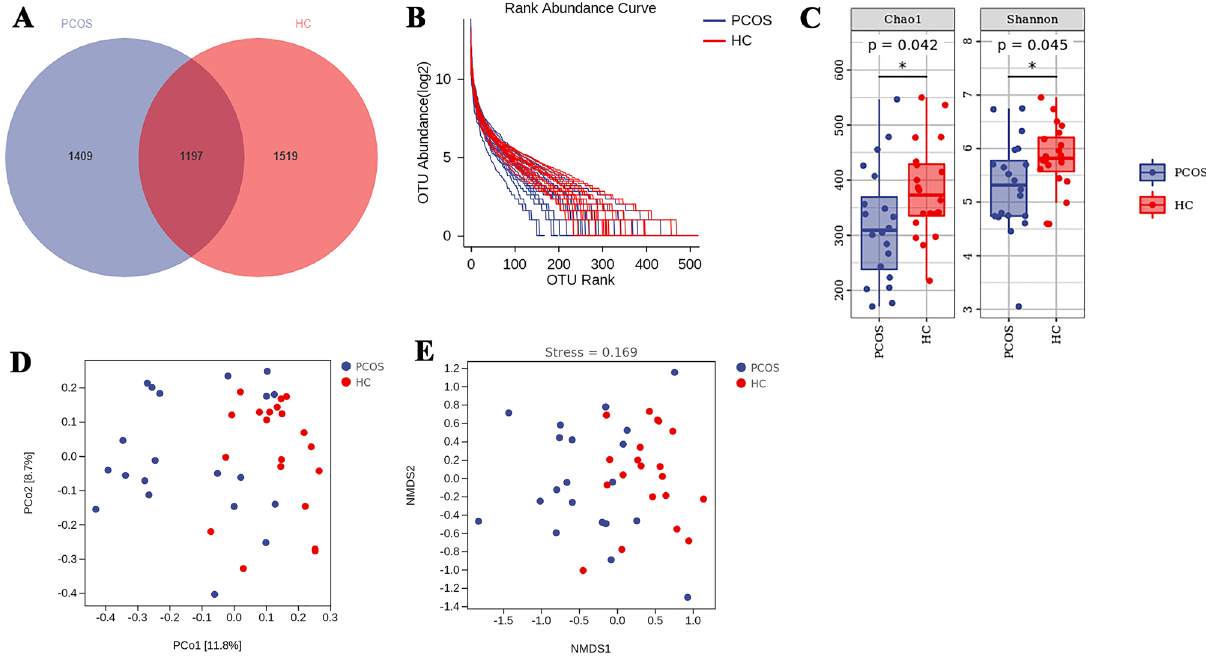
Figure 2. The dysbiosis of gut microbiota in the PCOS group. The ASVs Venn diagram of the PCOS and control ( A ); the rank abundance curve ( B ); alpha diversity, Chao1 index and Shannon index ( C ); PCoA analysis based on Bray–Curtis distance ( D ); NMDS analysis based on Bray–Curtis distance (stress = 0.169) ( E